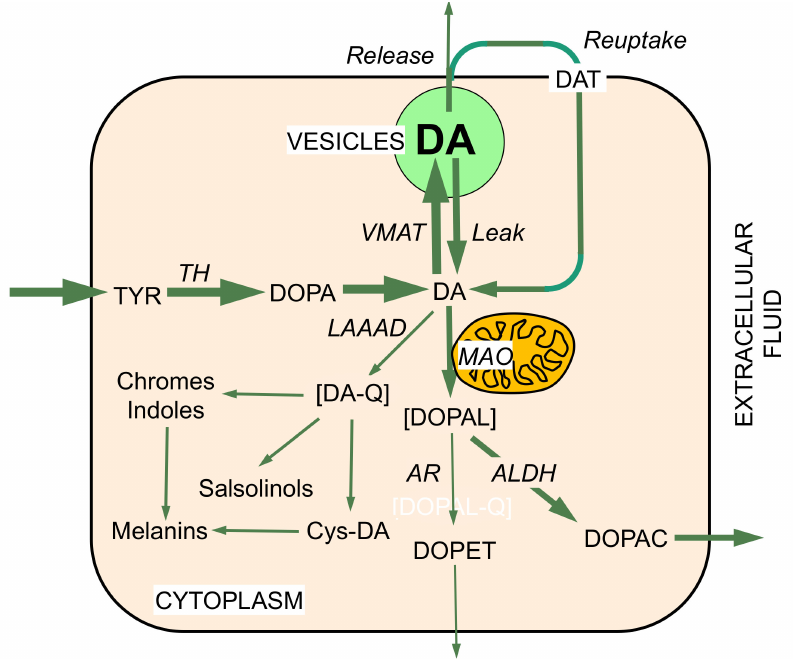
Figure 2. Dopamine synthesis, storage, reuptake, and metabolism. Dopamine (DA) is pro- duced in the neuronal cytoplasm via tyrosine hydroxylase (TH) acting on tyrosine to form 3,4- dihydroxyphenylalanine (DOPA) and then L-aromatic-amino-acid decarboxylase (LAAAD) acting on DOPA to form dopamine. Most of cytoplasmic DA is taken up into vesicles by way of the vesicular monoamine transporter (VMAT). This is balanced by passive leakage from the vesicles into the